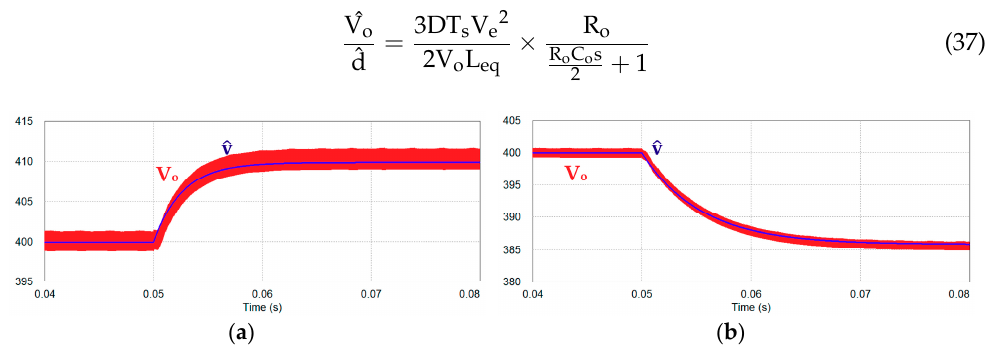
Figure 9. Simulated output voltage (V o ) and estimated output voltage ( ˆV): ( a ) duty cycle increased by 10% at rated power; ( b ) duty cycle decreased by 10% at 50% of rated